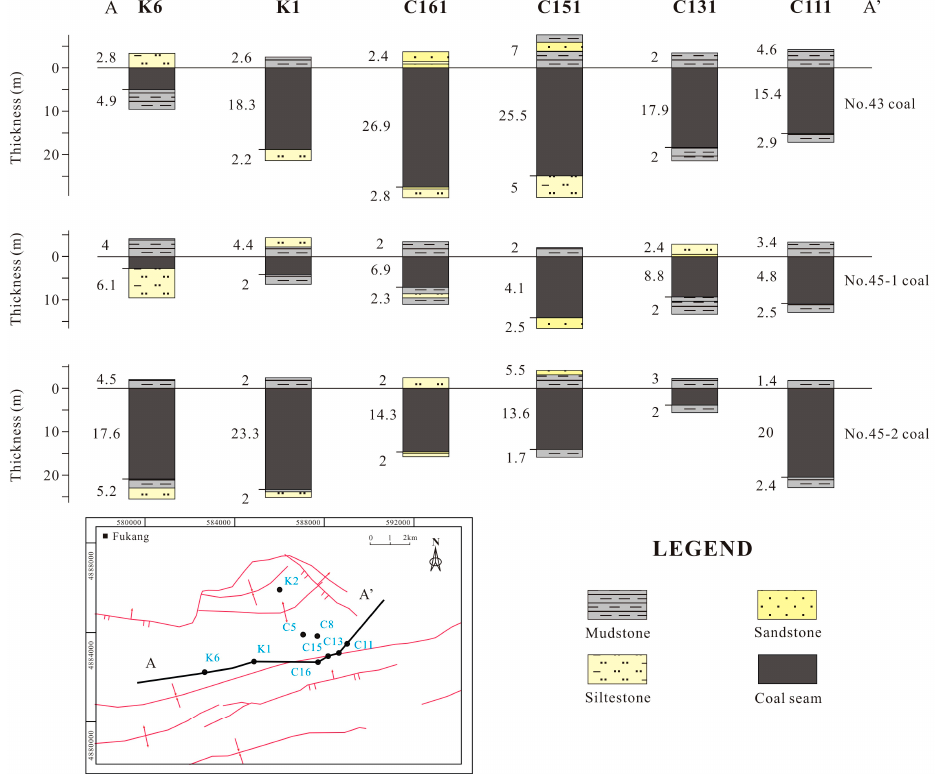
Figure 15 Figure 15. Cross section showing the effects of the roof lithology of the Nos. 43, 45-1, and 45-2 coal seams in the Fukang